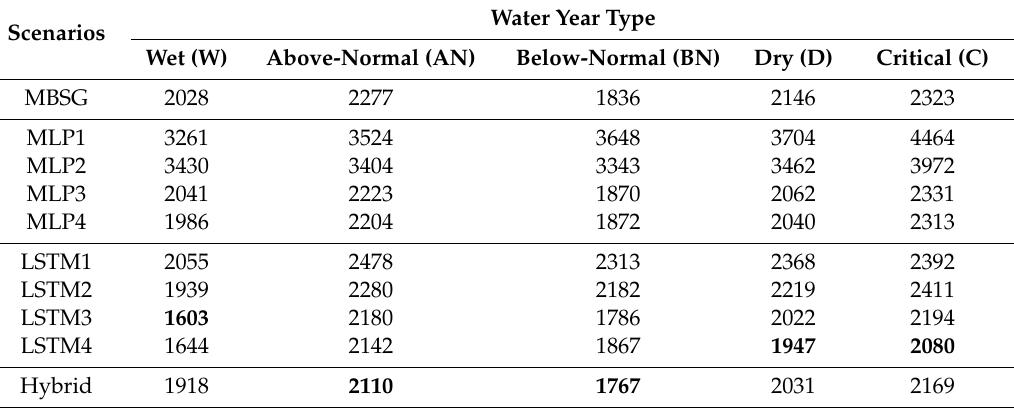
Table 4. Centered root mean square difference between reference and simulated Martinez salinity in different types of water years.